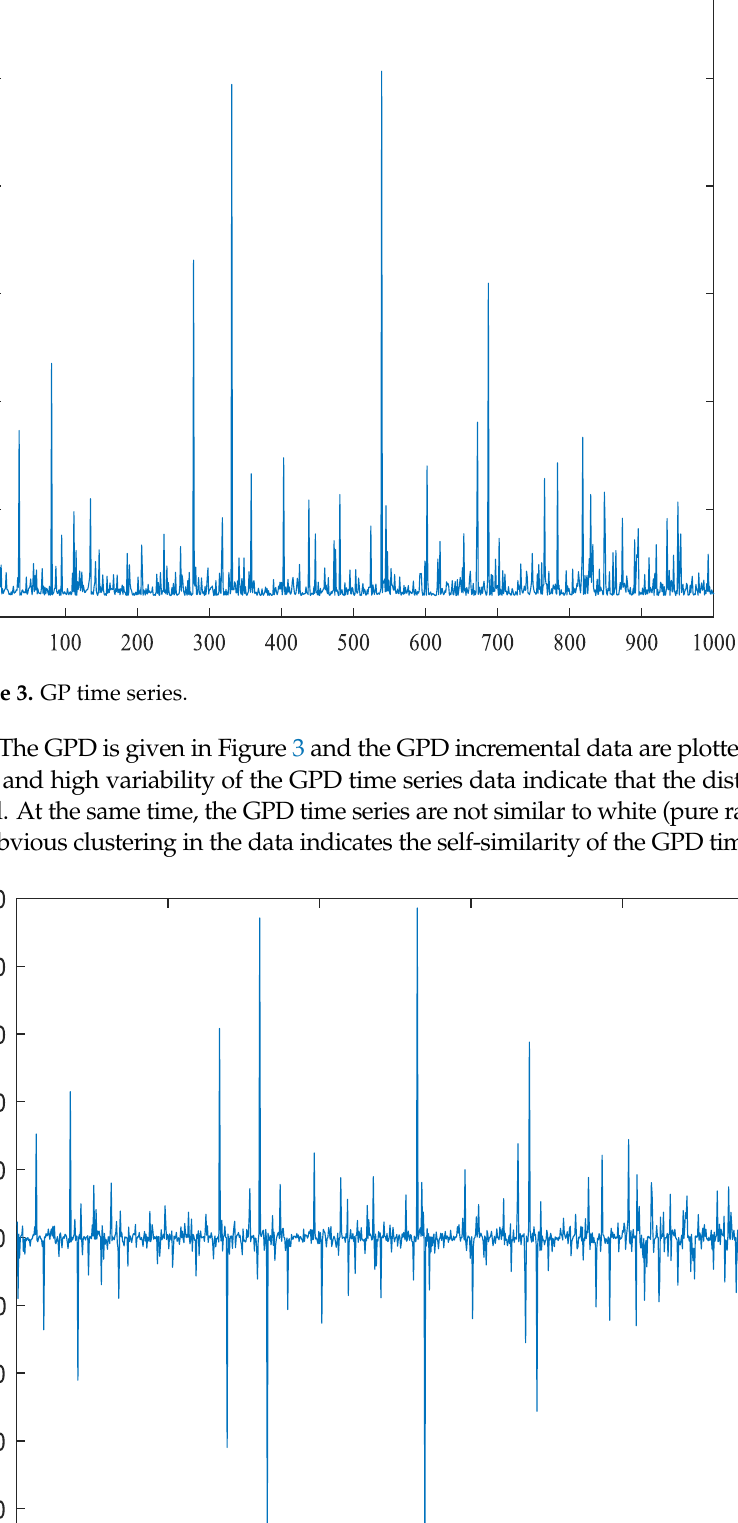
Figure 3. GP time series.